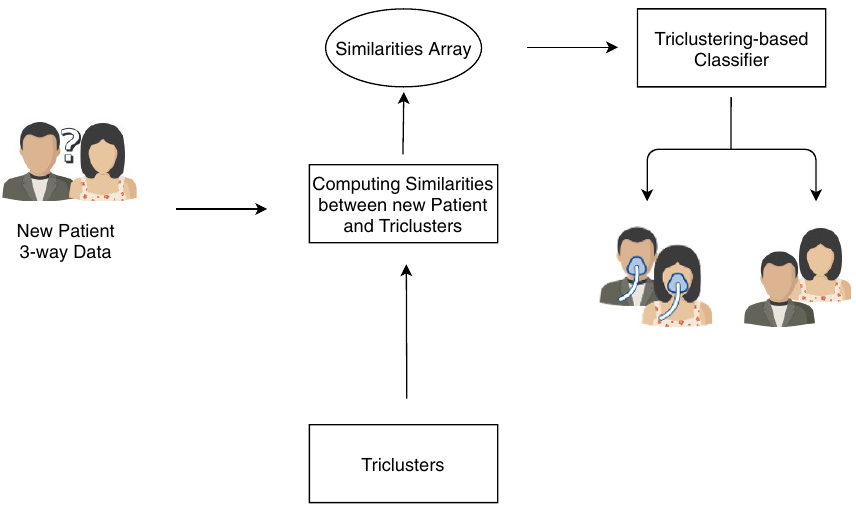
Figure 4. Example of using the triclustering-based classifier to classify new 3-way example from patient